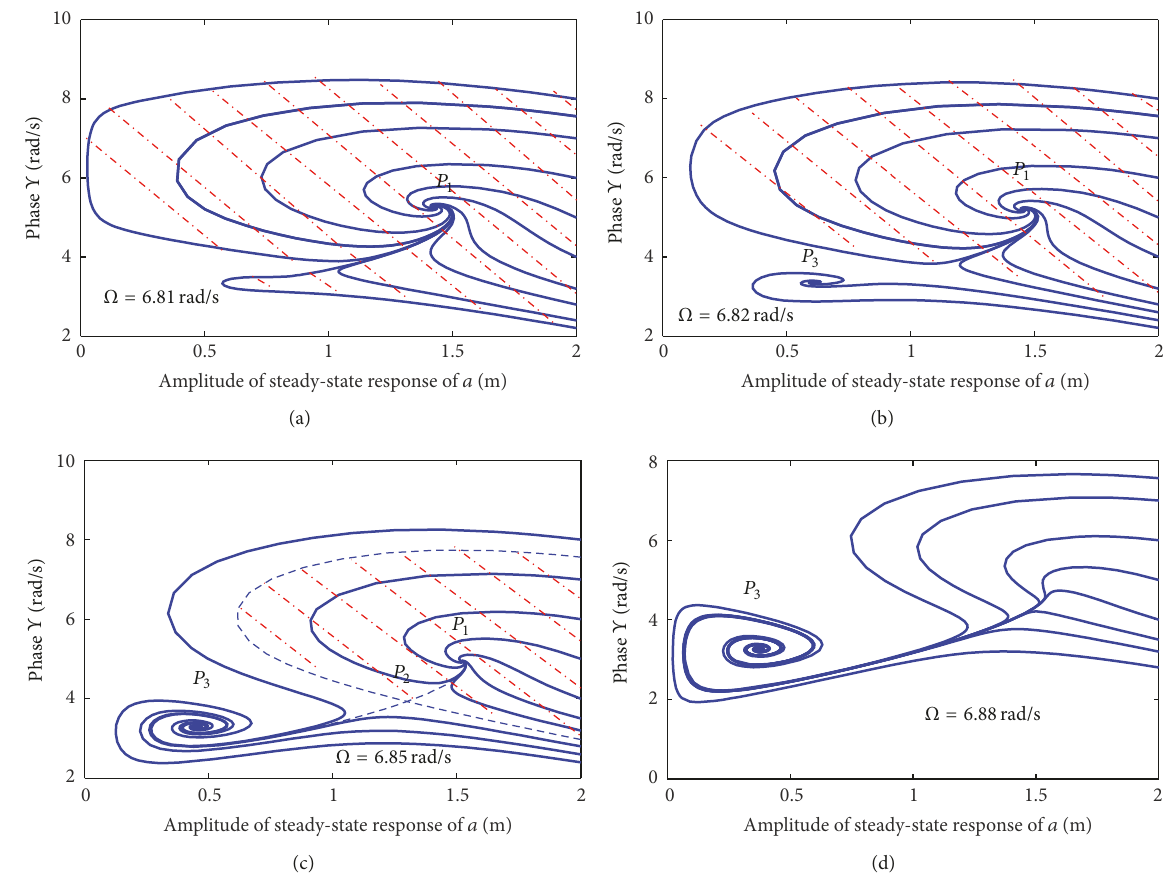
Figure 12: Evolution of the phase plane with the force frequency: (a) 6.81, (b) 6.82, (c) 6.85, and (d) 6.88